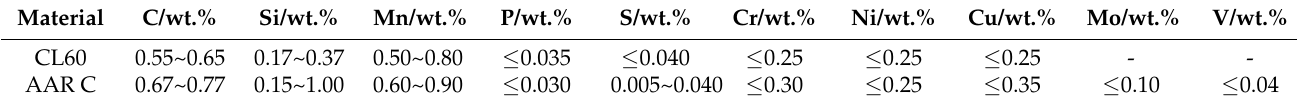
Table 1. Comparison of chemical composition in different standards.